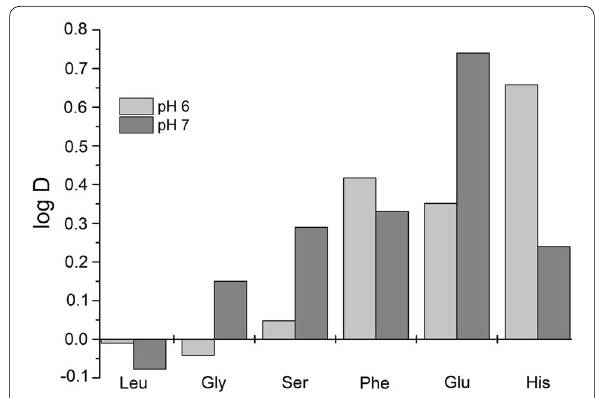
Fig. 2 Distribution ratios of free amino acids in IL-ATPS at pH 6.0 and 7.0